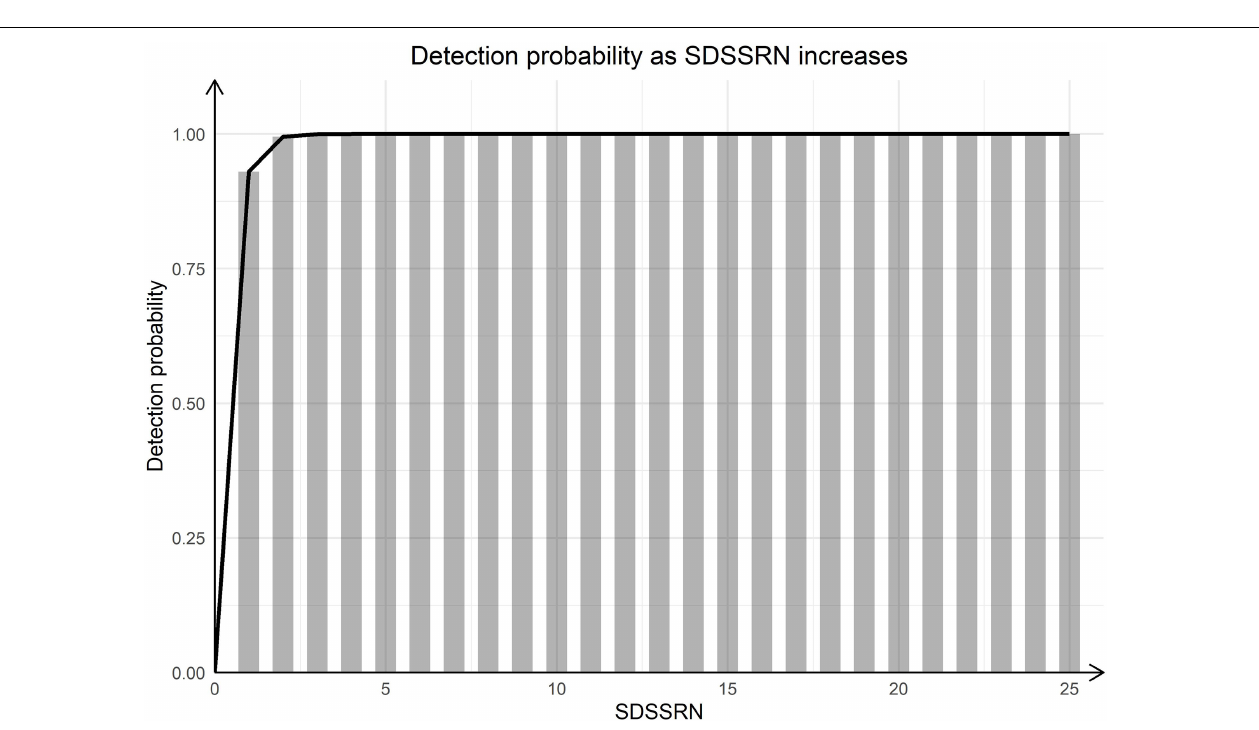
Frontiers in Microbiology |